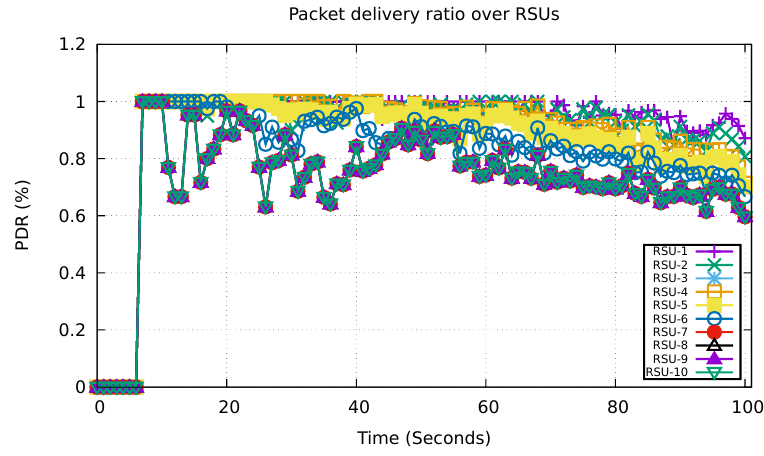
Figure 9. Packet delivery ratio over RSUs.